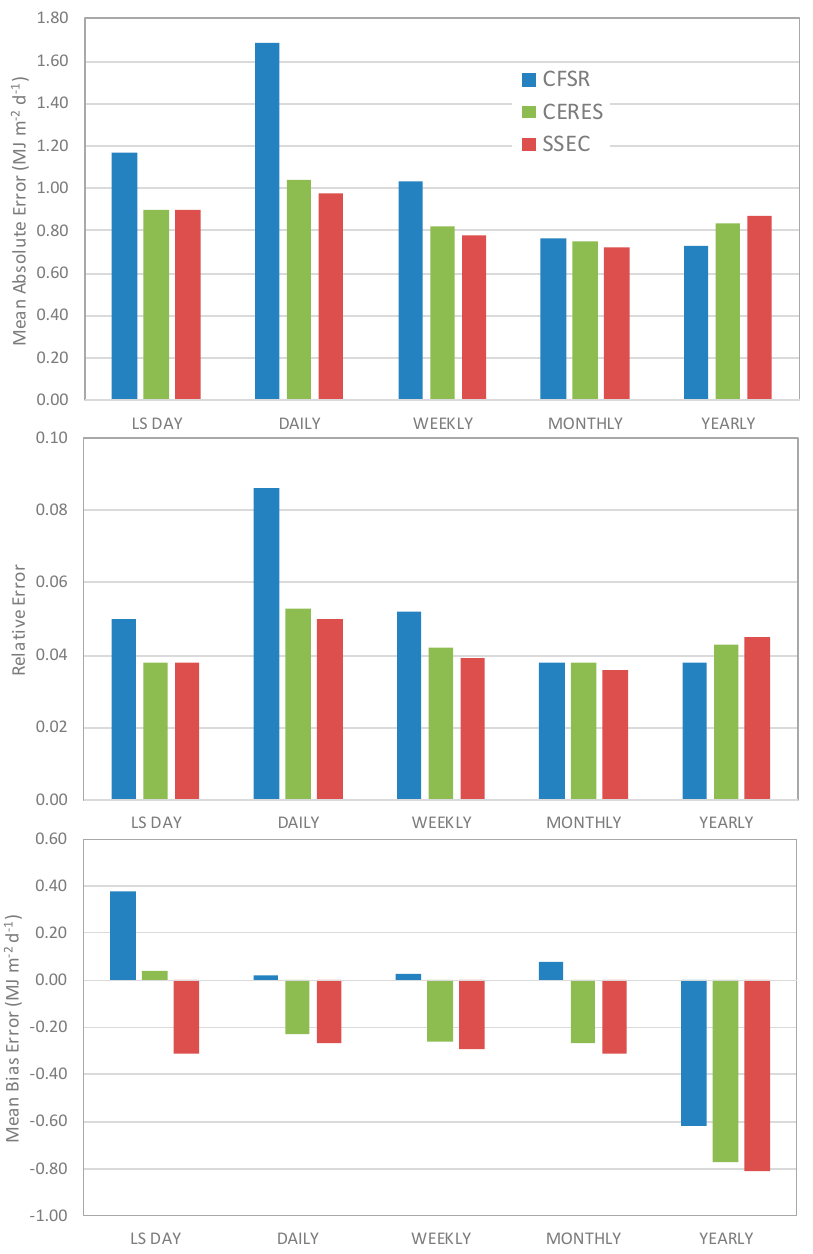
Figure 4. Mean absolute error (MAE), relative error (RE), and mean bias error (MBE) in insolation products on clear Landsat overpass dates (LS DAY) and at daily, weekly, monthly, and yearly timesteps over the study period.